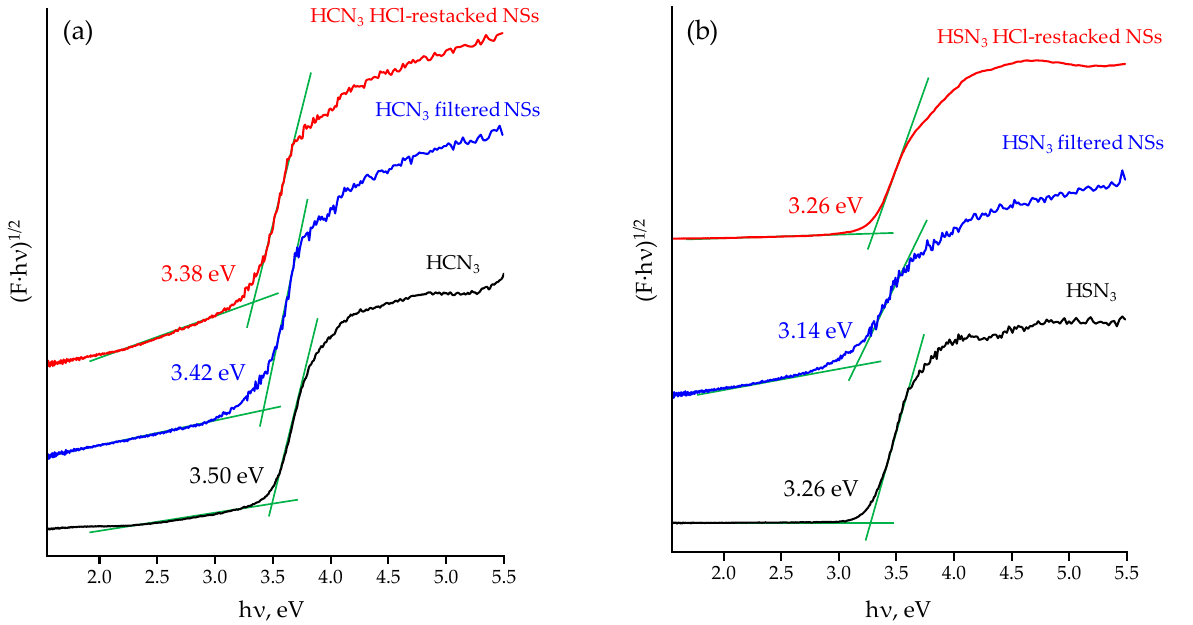
Figure 3. Tauc plots for the protonated forms and reassembled nanosheets of HCN 3 ( a ) and HSN 3 ( b ) niobates.